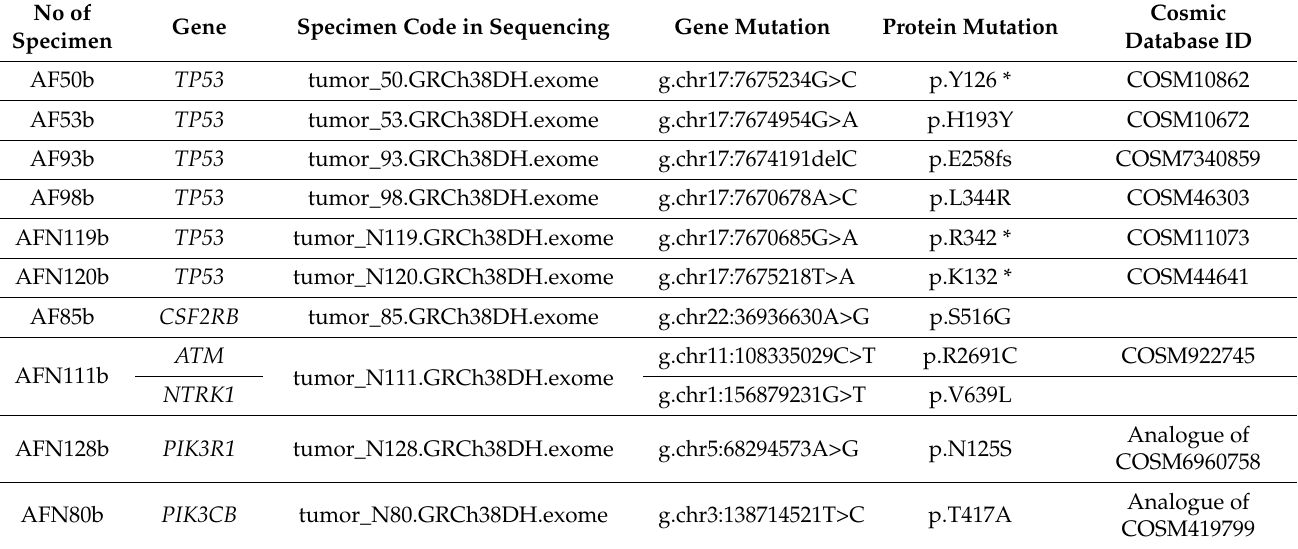
Table 4. Chemoresistance of cancer cells in the primary STS cultures depending on the somatic mu- tational status of apoptosis activation pathway genes *.